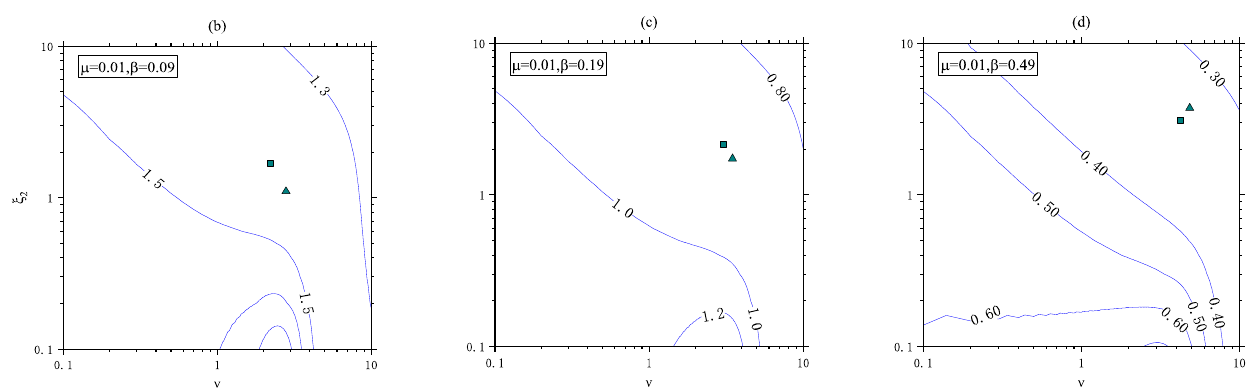
Figure 7. Relative displacement variance σ 2 in the variation interval of parameters ν and ξ 2 . ( a ) β = 0 and ( b ) β = 0.09 and ( c ) β = 0.19 and ( d ) β = 0.49.